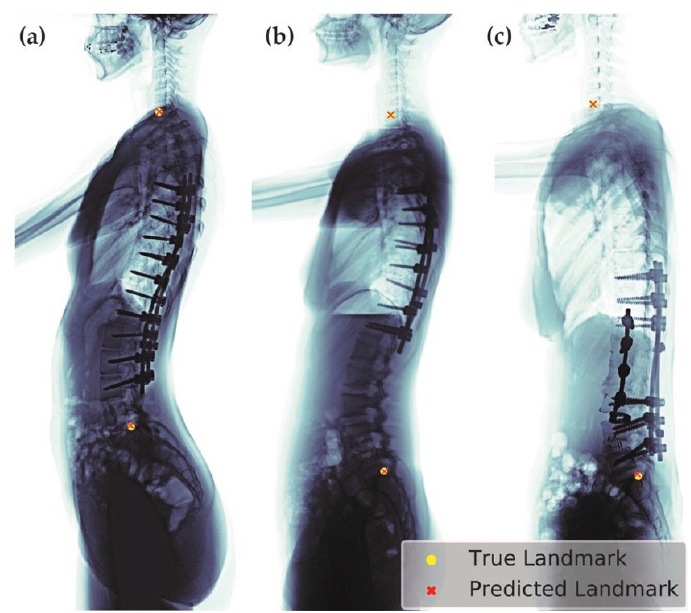
Figure 10. Examples of predicted images of post spinal fusion surgery with varied length of implants: ( a ) thoracic-lumbar fusion; ( b ) thoracic fusion; and ( c ) lumbar-sacral fusion.